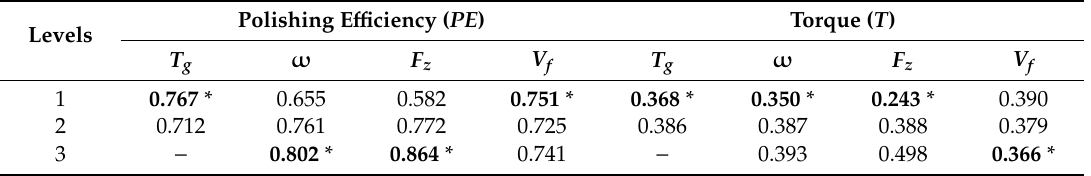
Table 7. Cell mean of the control factor Response table for cell